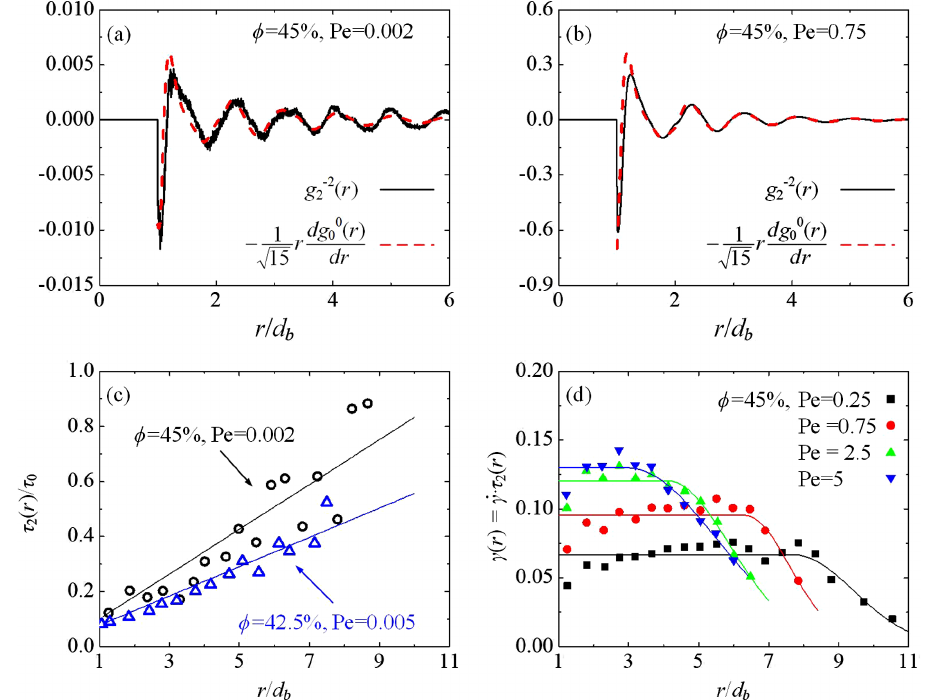
ffiffiffiffiffi p 15 Þ rdg 0 0 ð r Þ =dr of the ϕ ¼ 45% system at Pe ¼ 0 . 002 (Newtonian regime) and 0.75 ffiffiffiffiffi p 15 Þ rdg 0 0 ð r Þ =dr is rescaled to match that of g − 2 2 ð r Þ in both (a) and (b).